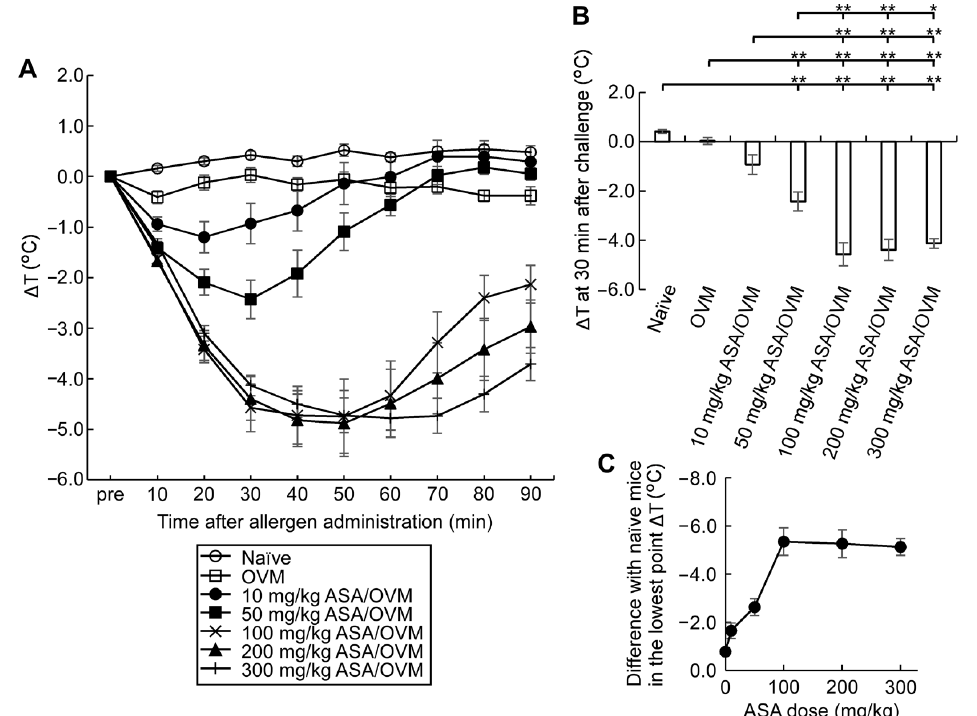
Figure 3. Dose-dependent effect of ASA on fall in rectal temperature after oral allergen challenge. ( A ) ΔT after 20 mg OVM challenge in allergen -sensitized and naïve mice with and without 30 min pre-medication with each ASA dose ( n = 5–10/group); ( B ) Δ T correlations between sensitized and naïve mice with and without pre-medication of ASA; ( C ) Dose-dependent effect of pre-medication of ASA on the lowest point ΔT in sensitized mice compared with naïve mice after OVM challenge. Data are mean ± SEMs. * p < 0.05, ** p < 0.01.